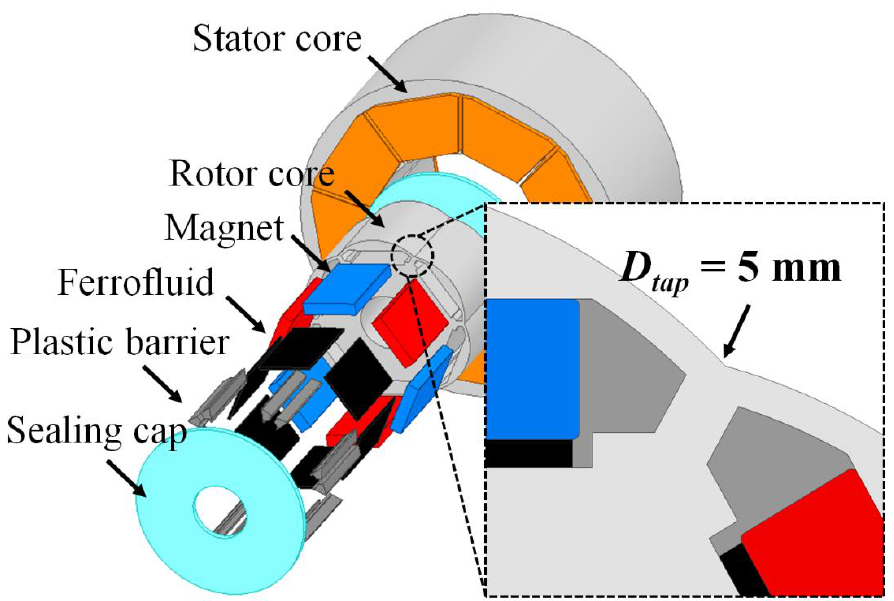
Figure 18. The final model injected with ferrofluid.